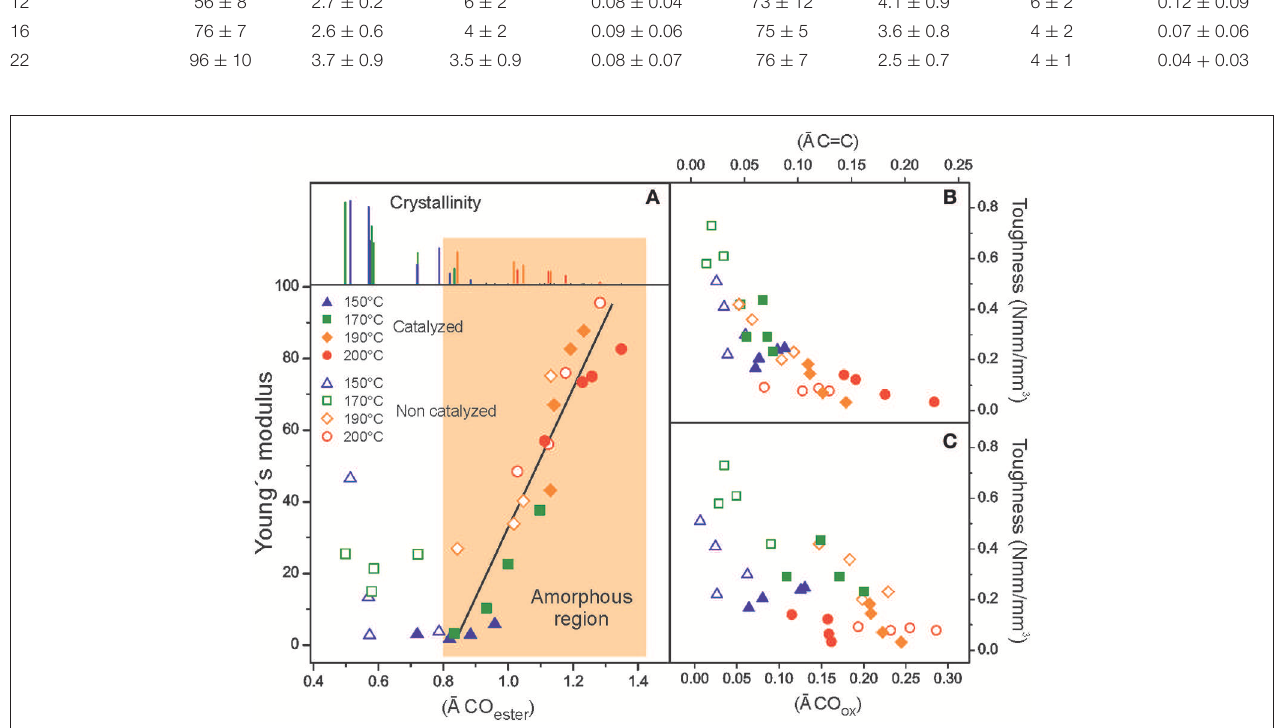
FIGURE 5 | (A) Relationship between the elastic modulus and the intensity of the ester carbonyl ATR band in polyaleuritates synthesized in air. The dependence is well-defined for amorphous samples (light orange area). Tensile toughness variation with the presence of (B) dehydration, and (C) oxidation by-products.